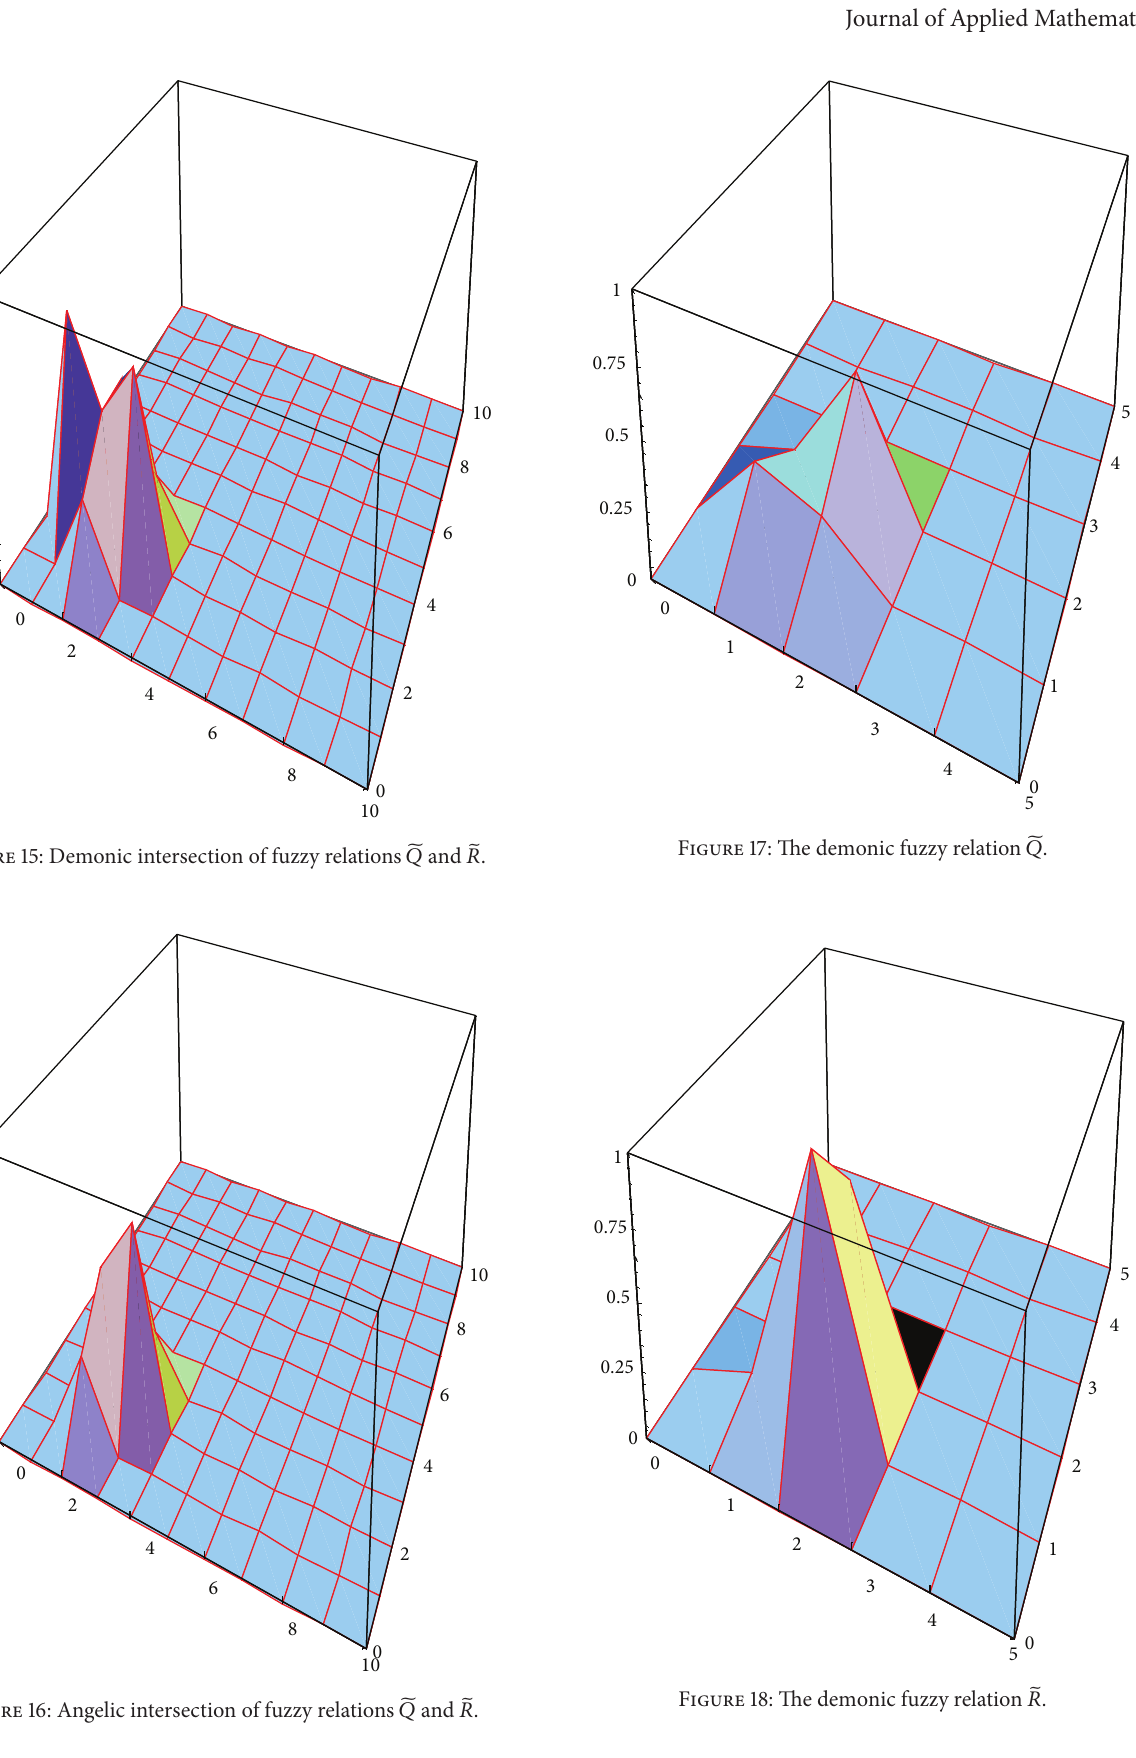
Figure 16: Angelic intersection of fuzzy relations